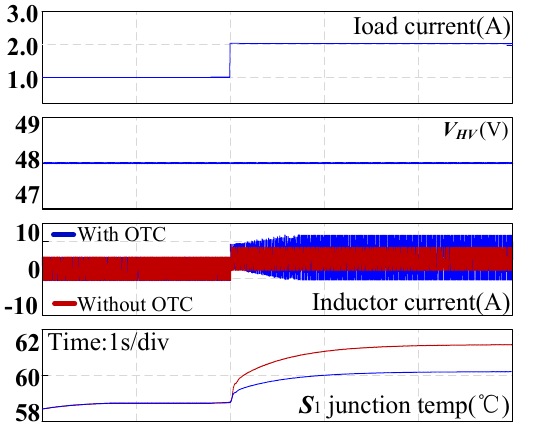
Figure 9. Simulation waveforms of 24 V input voltage to 48 V output voltage for a load current step from 2 A to 1 A with 100 W rated power.